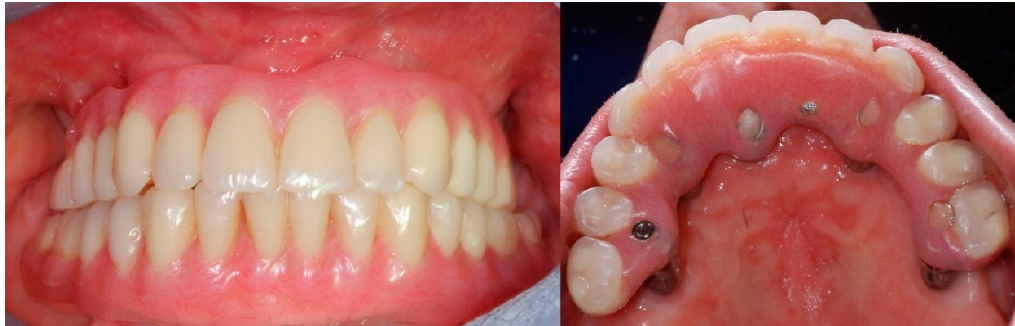
Figure 7. The screw-retained immediate loaded prosthesis and the occlusal view of the implant prosthetic emergences.